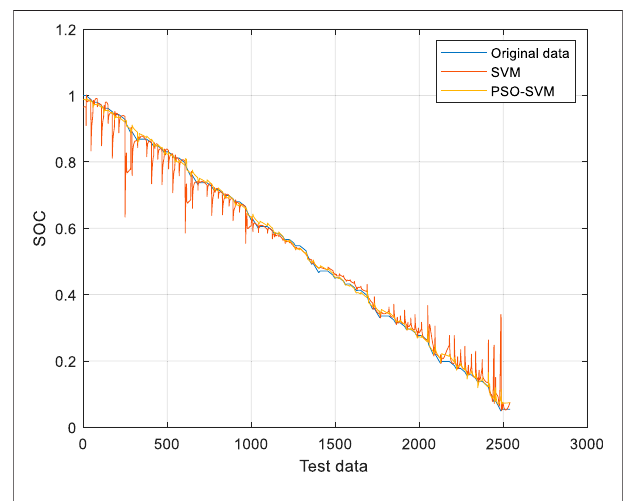
FIGURE 15 | DST working condition veri fi cation.